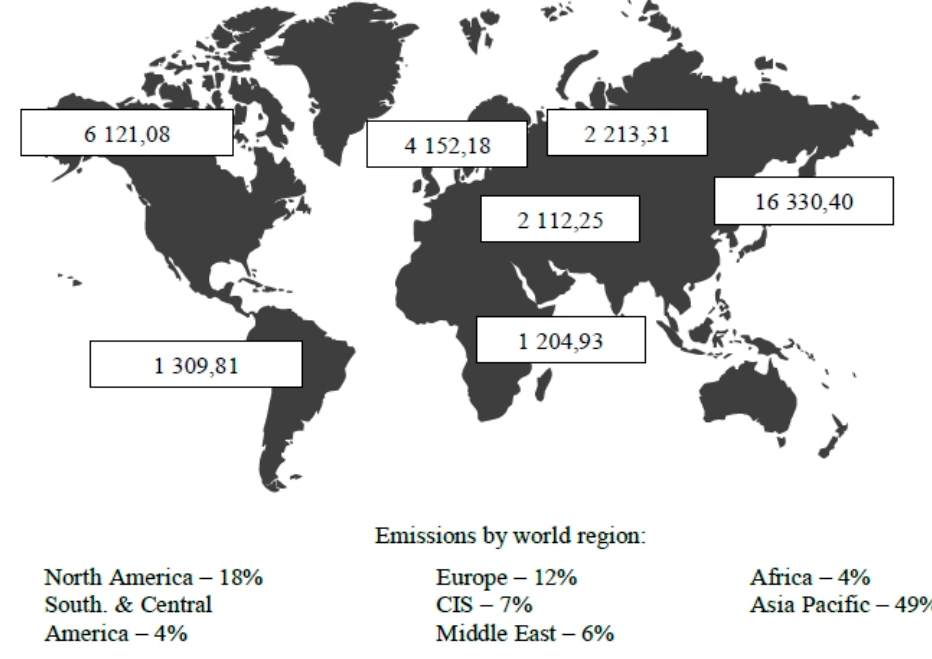
Figure 8. World carbon dioxide emissions by region (in million metric tons of carbon dioxide). Source: BP Statistical Review of World Energy (2018).